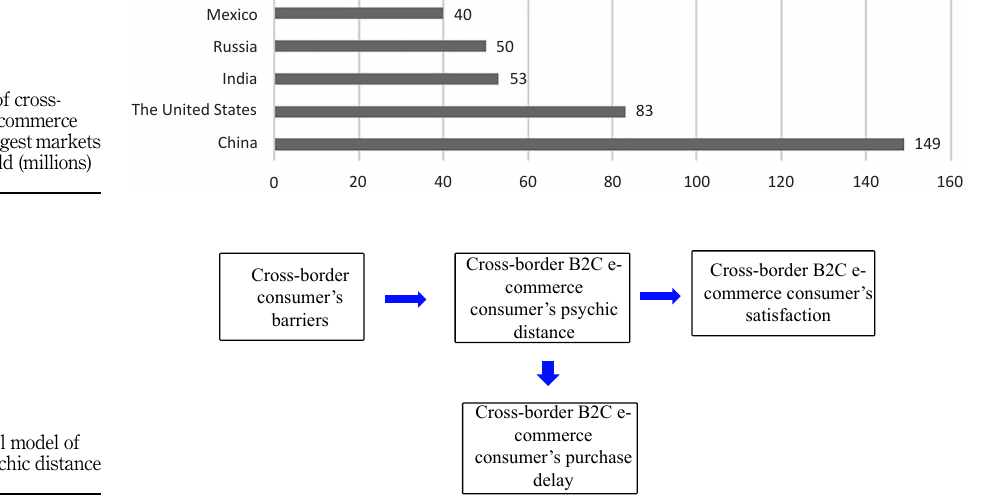
Figure 1. E-buyers of cross-